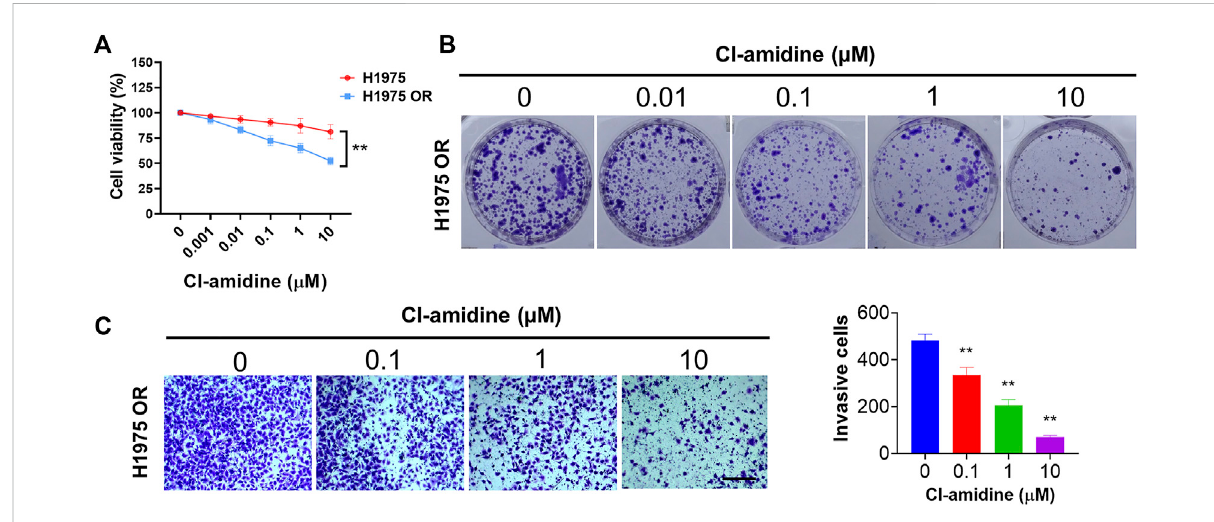
FIGURE 7 PADI inhibitor inhibited the proliferation,colony formation, and invasion of H1975 OR cells. (A) The graph shows thepercentcell viability (CCK- 8 assay) of H1975 cells and H1975 OR cells after 72-h treatment with the indicated doses of Cl-amidine. Data are presented as mean ± SD. (** p < 0.01 vs. H1975; n = 3). (B) Colony formation assay shows the inhibitory effect of indicated doses of Cl-amidine on colony formation of H1975 OR cells. (C) TranswellinvasionassaysforH1975ORcellsuponexposuretotheindicateddosesofCl-amidinefor12 h.Thelengthofthescalebaris 400 μ m. Column graphs show the quantitative measurement of invasive cells. Data are presented as mean ± SD. (** p < 0.01 vs. Cl-amidine 0 μ M; n =